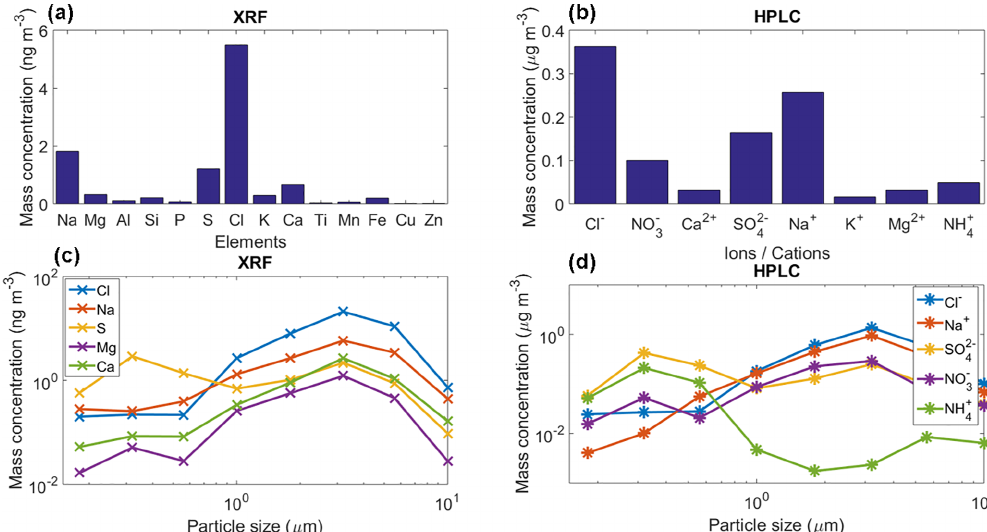
Figure 8. (a) Mean mass concentration of 14 detected elements for the collected aerosol particles using XRF, (b) mean mass concentration of eight detected ions for the collected aerosol particles using HPLC, (c) and (d) mean mass size distribution of the main five detected elements/ions with the XRF and HPLC. These results are the average for the whole sampling